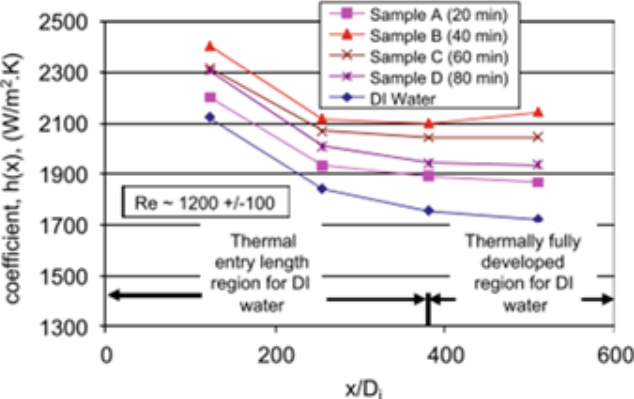
Figure 19. Axial variation of heat transfer coefficient at Re = 1200 ± 100 under varying sonication time using MNF. Adapted from [155].